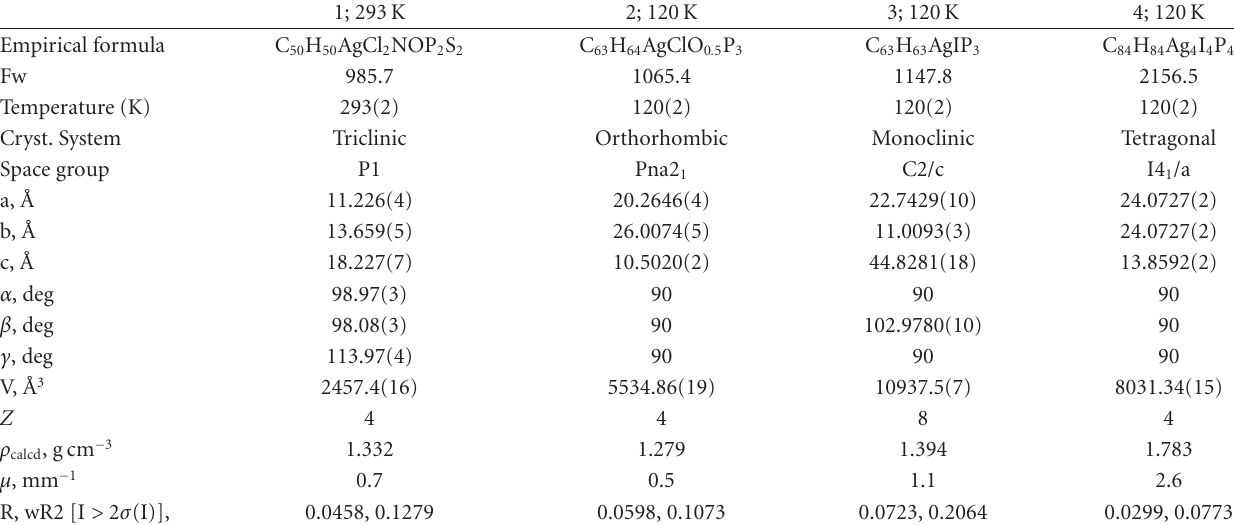
Table 2: Crystal data and structure refinement details for complexes 1–4